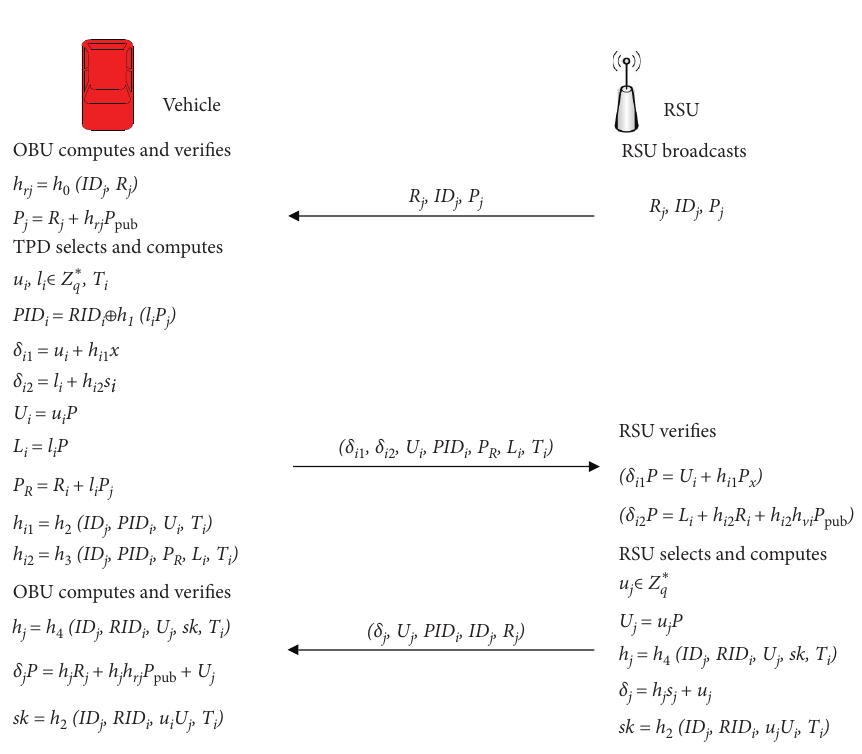
Figure 2: Mutual authentication and key agreement. Table 1: Notations